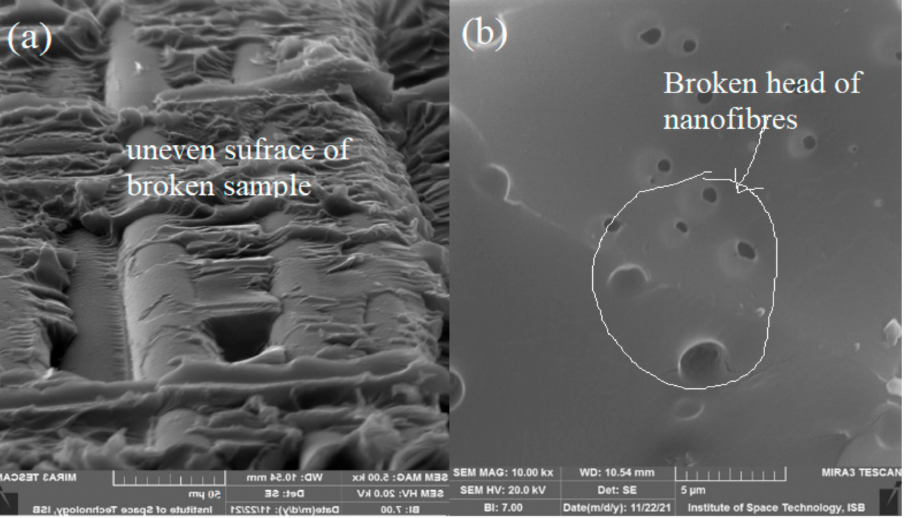
Figure 14. SEM image of tensile test of 0.5% CA + 32% glass fiber composite. ( a ) Plane breakage of a composite ( b ) broken fiber